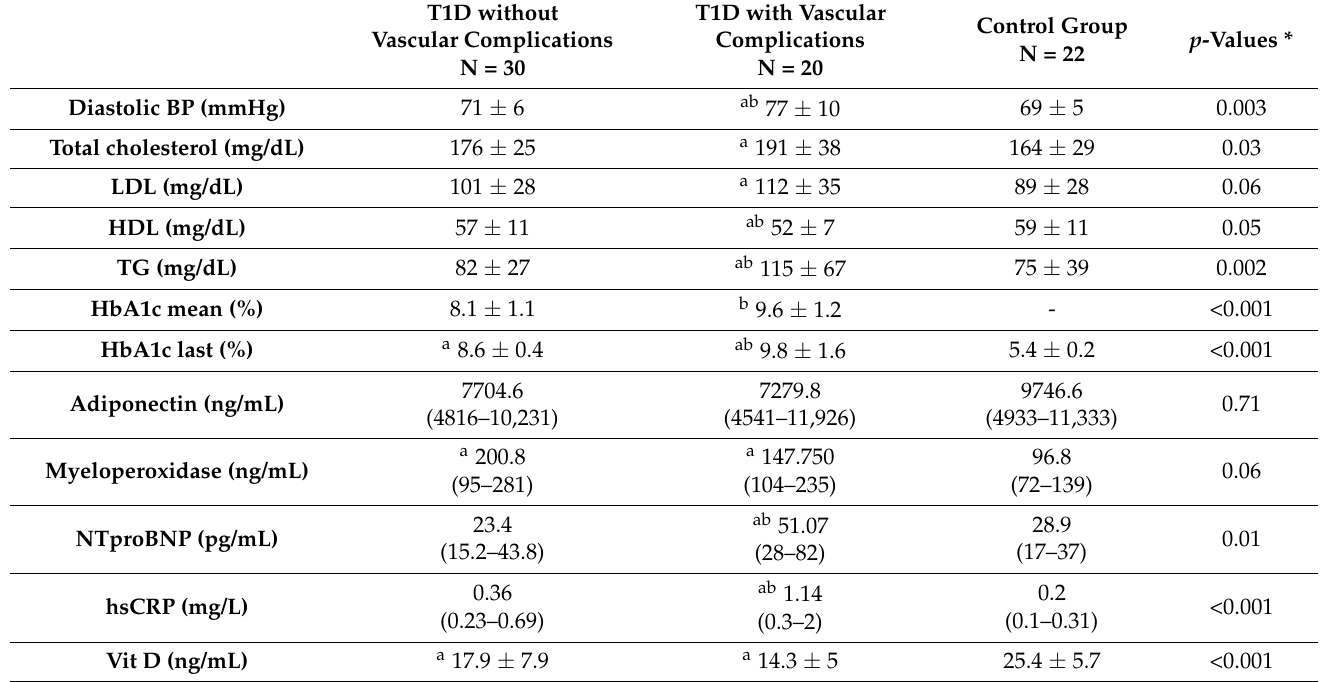
Table 2. Clinical characteristics, lipids, metabolic control, “new biomarkers” of cardiovascular disease between study groups. The results are presented as mean ± SD or median (interquartile Table 2. Cont.